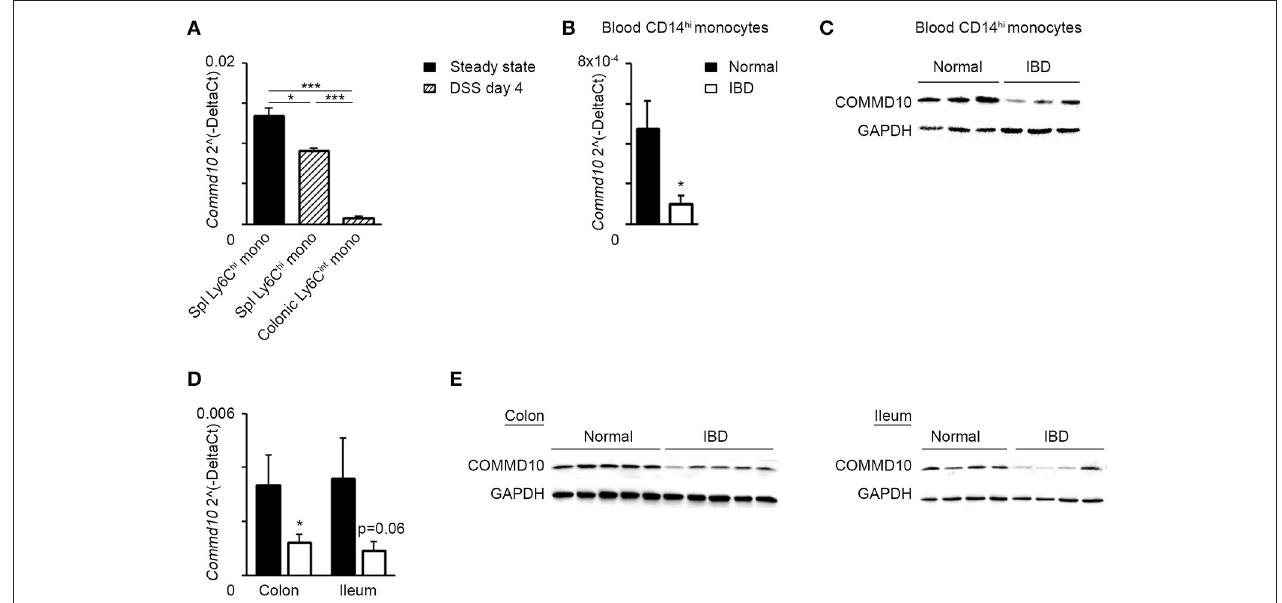
FIGURE 7 | COMMD10 is downregulated in mouse Ly6C hi monocytes and their equivalent human CD14 hi monocytes during intestinal inflammation. (A) Splenic and colonic Ly6C hi monocytes were sorted from steady state mice (solid) or at day 4 of DSS (diagonal). (B,C) Circulating CD14 hi monocytes were sorted from patients with active IBD (black border) or healthy controls (solid). (B) qRT-PCR gene expression of Commd10 and (C) immunoblot demonstrating COMMD10 protein expression. GAPDH was utilized as control ( n ≥ 3). (D,E) Biopsies were obtained from colons and terminal ileums of IBD patients with active disease and healthy controls. (D) qRT-PCR analysis of Commd10 gene expression. (E) Immunoblots demonstrating COMMD10 protein expression in colon (left panel) and ileum (right panel) biopsies obtained from IBD patients vs. healthy controls. GAPDH was utilized as controls ( n ≥ 14). Data were analyzed by unpaired, two-tailed t- test, comparing each time between IBD with healthy controls. Results are presented as mean ± SEM with significance: * p < 0.05, *** p < 0.001. Data in (A–C) represent a single